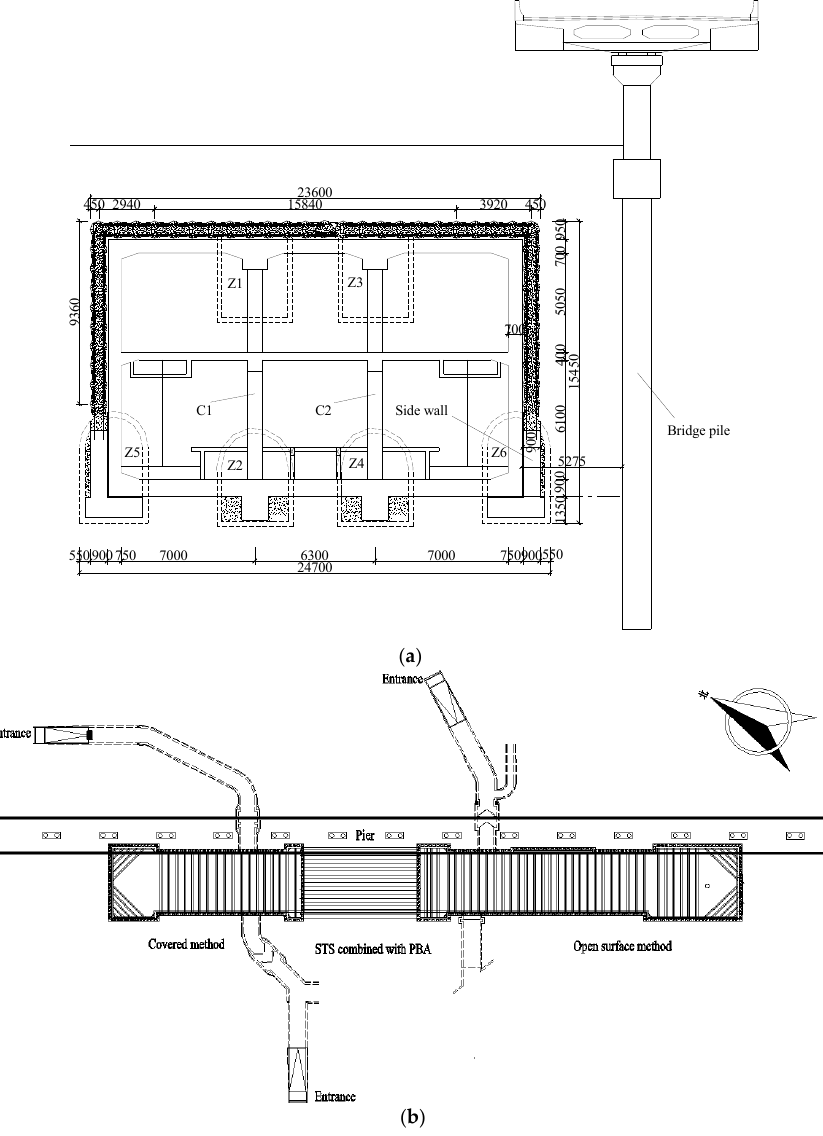
Figure 4. Layout of the Northeast Street station: ( a ) Cross section; ( b ) General plan.